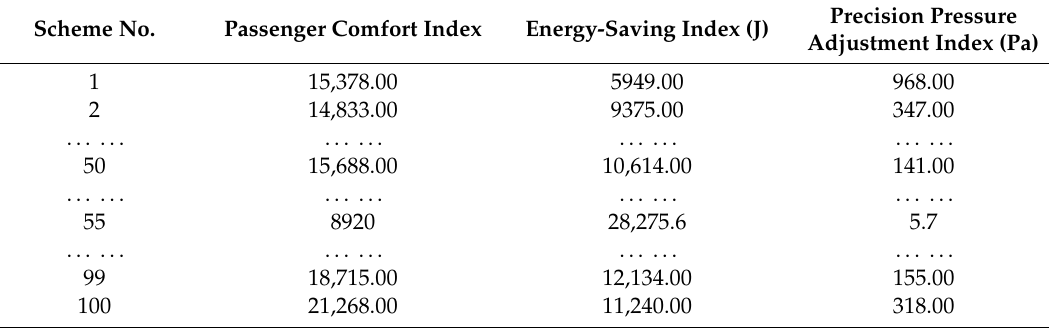
Table 3. Objective function value corresponding to the optimal solution